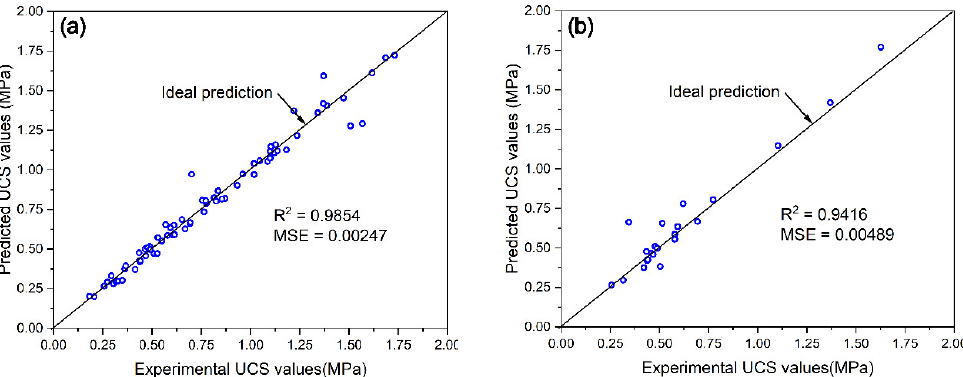
Figure 10. Prediction results based on categorized randomly segmented dataset on ( a ) the training set and ( b ) the test set.